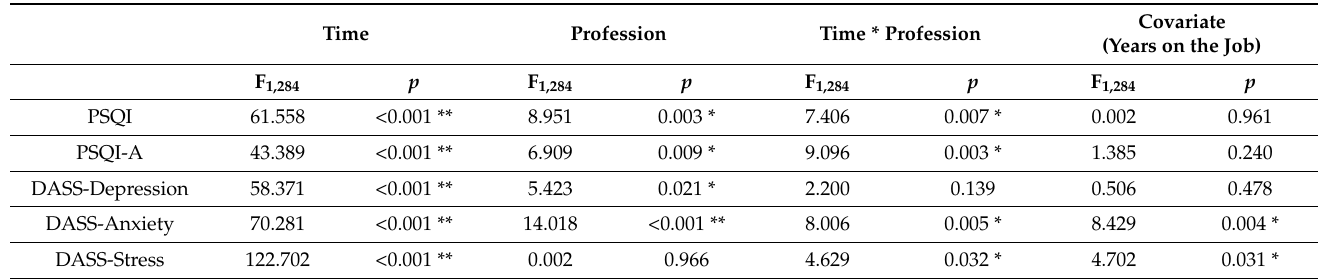
Table 2. Univariate test of the two-way mixed MANCOVA with “Years on the job” as covariate and “Time” and “Profession” as within and between factors, respectively.